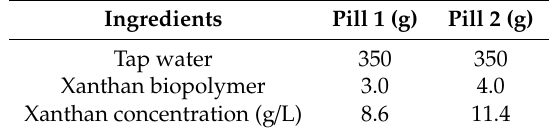
Table 2. Mix design and mixing procedure for the viscous pills.